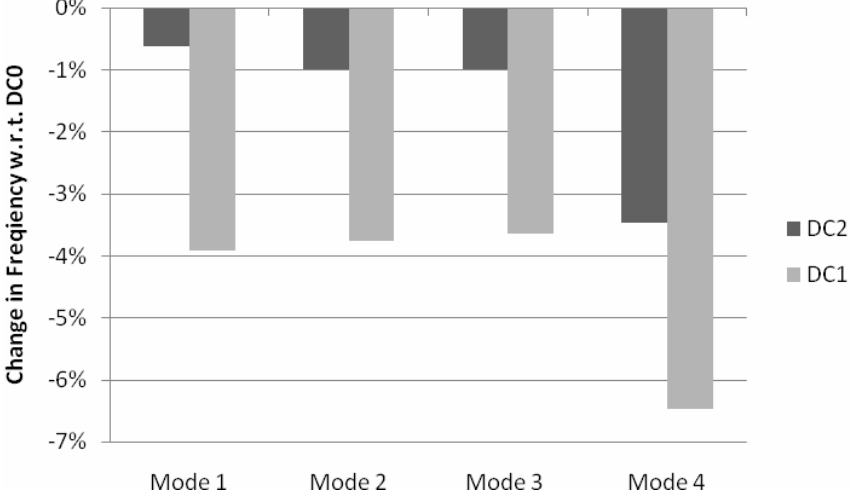
Fig. 17. Change in identified modal frequencies due to damage (OKID).